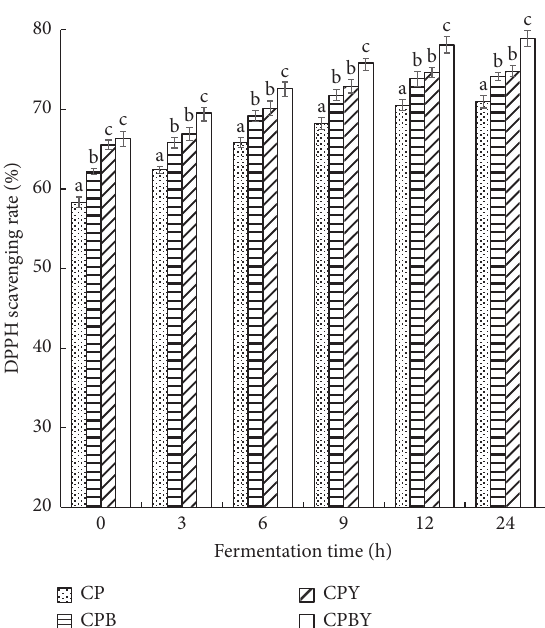
Figure 4: DPPH free radical scavenging rate of four samples at different fermentation times. All the values are expressed as mean ± SD ( n � 3). Means with different lowercase letters indicate a significant difference of four group samples at the same fermentation time ( p < 0 . 05). CP, chickpea fermentation milk; CPB, chickpea fermentation milk with enzyme hydrolysis; CPY, chickpea yam fermentation milk; CPBY, chickpea yam fermentation milk with enzyme hydrolysis.